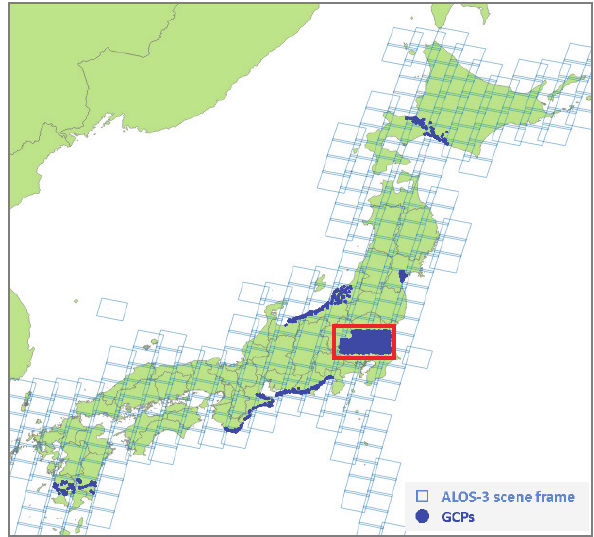
Figure 2. Preparation status of precise GCPs in Japan